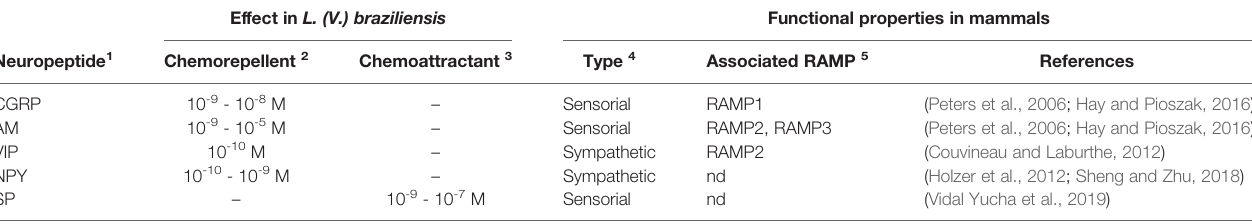
TABLE 1 | Chemotactic effect of selected neuropeptides in L. (V.) braziliensis. Effect in L. (V.)